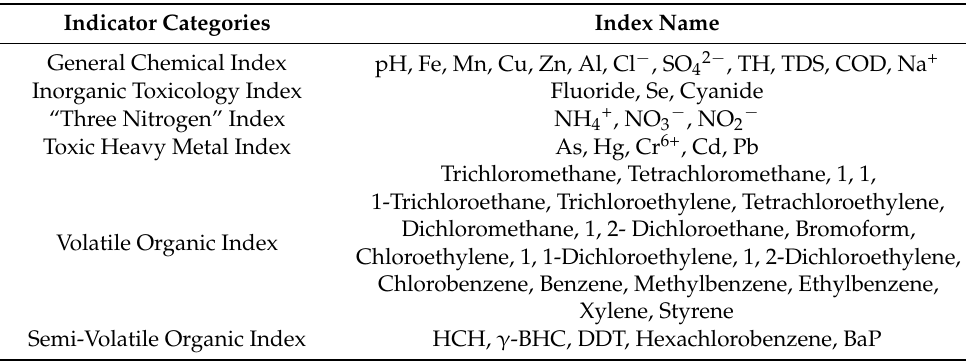
Table 2. Multi-index classification of